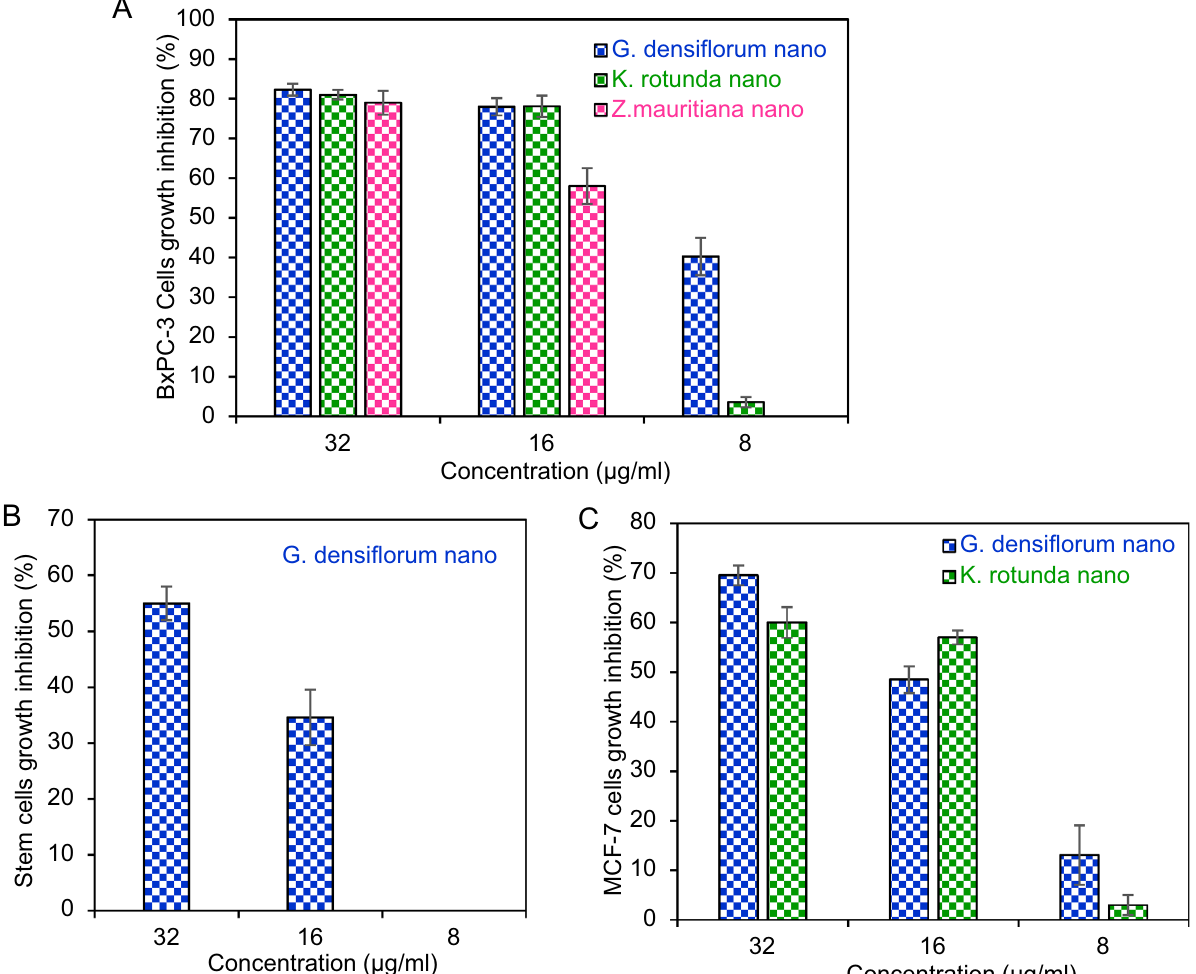
Figure 3. Antiproliferative activity against BxPC-3, GSCs and MCF-7. ( A ) Antiproliferative activity of G. densiflorum -Ag/AgCl-NPs, K. rotunda -Ag/AgCl-NPs and Z. mauritiana -Ag/AgCl-NPs against the BxPC-3. ( B ) Antiproliferative activity of G. densiflorum -Ag/AgCl-NPs against the GSCs. ( C ) Antiproliferative activity of G. densiflorum -Ag/AgCl-NPs and K. rotunda -Ag/AgCl-NPs against the MCF-7 cells. After incubation of the cells with different concentrations of Ag/AgCl-NPs, the inhibition ratio was calculated by Microsoft excel software (n = 3, mean ±